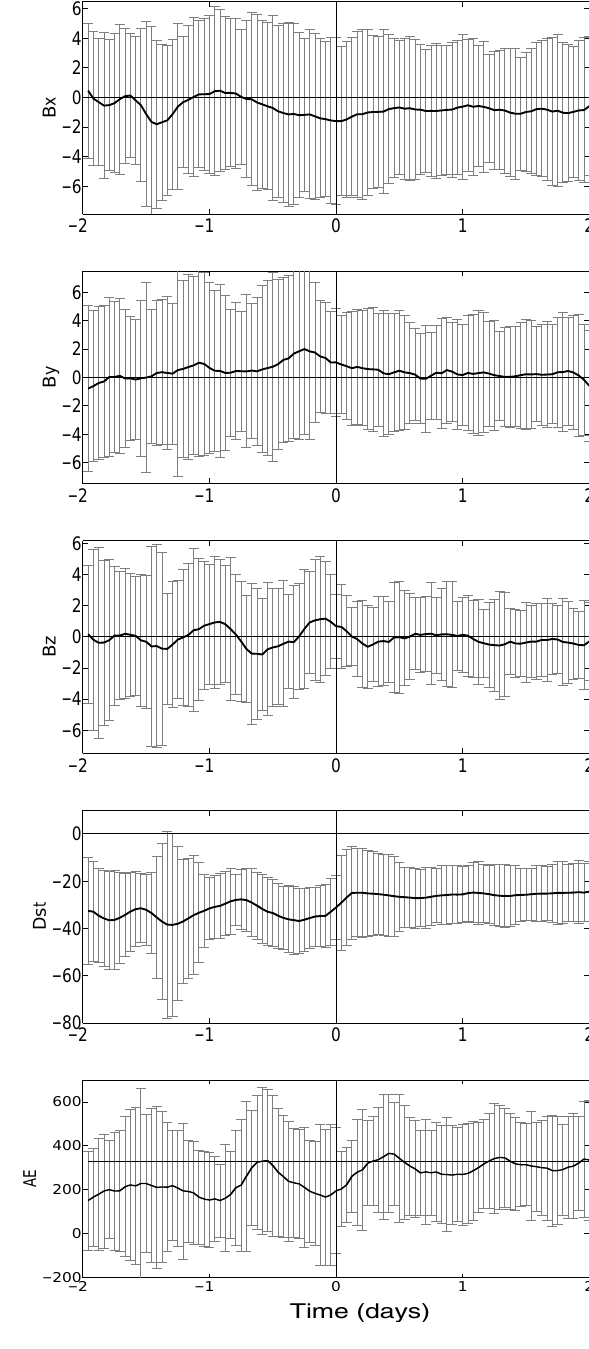
Figure 4. From top to bottom and from left to right, panels show the SEA results of solar wind speed ( V sw in kms − 1 ), plasma density ( N sw in cm − 3 ), temperature ( T sw in K), flow pressure ( P sw in nPa), IMF magnitude ( B o in nT), the B x (nT), B y (nT), B z (nT) components in the GSM coordinate system, and the Dst (nT) and AE (nT) indices, respectively. The curves show the average values while the vertical bars show the standard deviations. On the horizontal axis, the zero epoch time corresponds to the HILDCAAs* onset, and the SEA is performed from 2 days prior to 2 days after the zero epoch